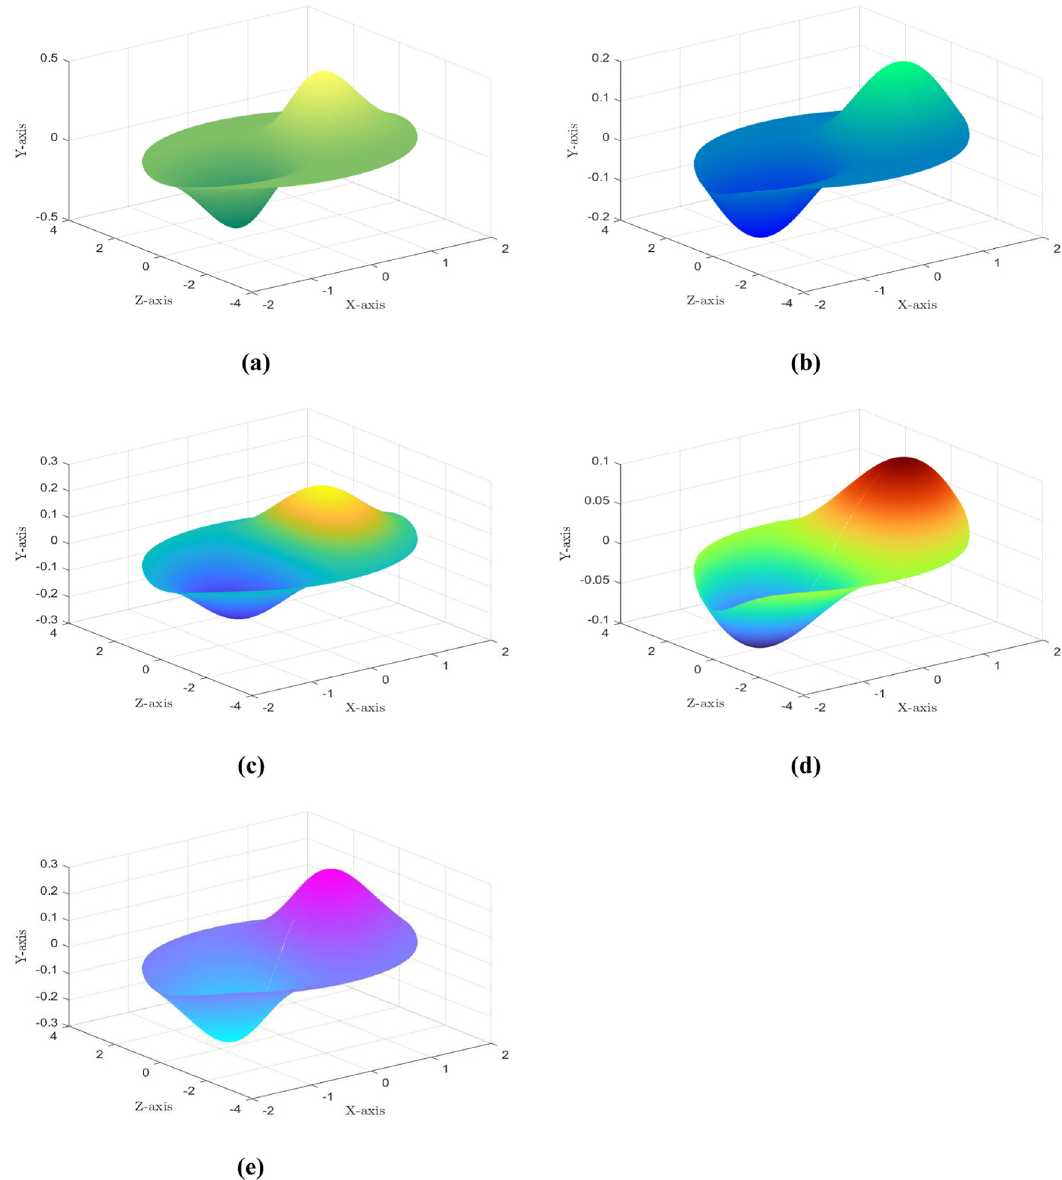
Figure 3: Bernstein operators, product operator and Boolean sum operator approximating function ( operator (cid:5) G mn